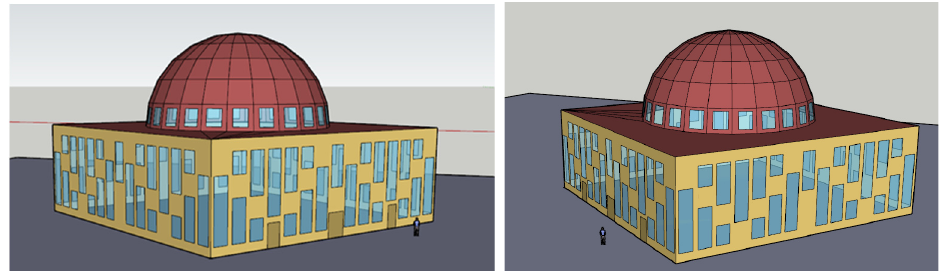
Figure 3. Outdoor façades of the base mosque scenario.